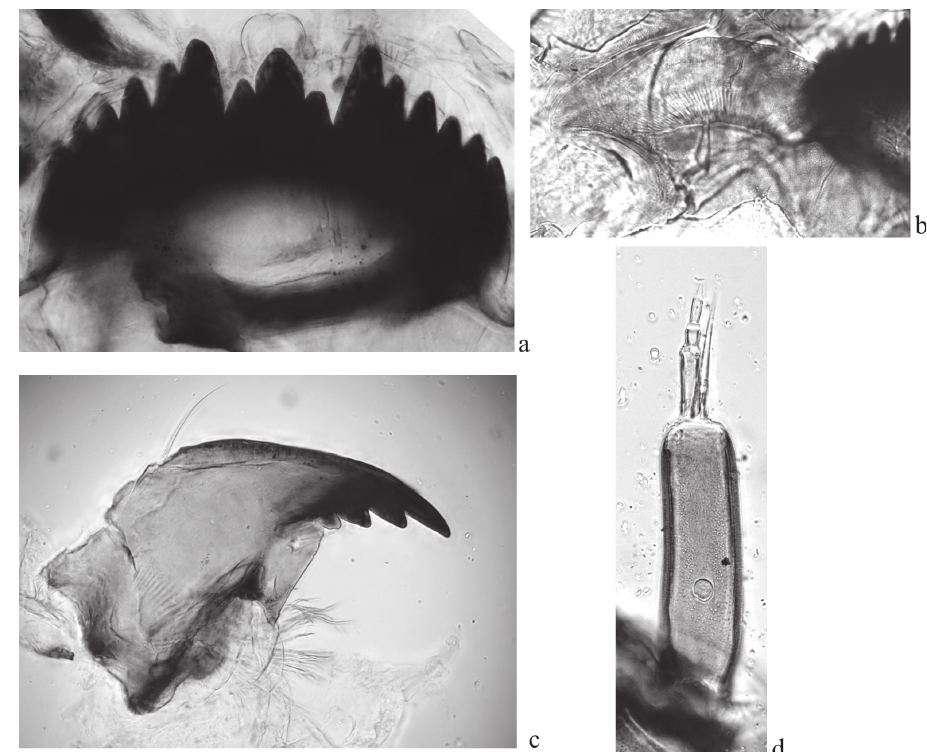
Figure 2. Larva morphology of Ch. heteropilicornis from the Gydan peninsula, Russia a mentum b ven- tromental plate c mandible d